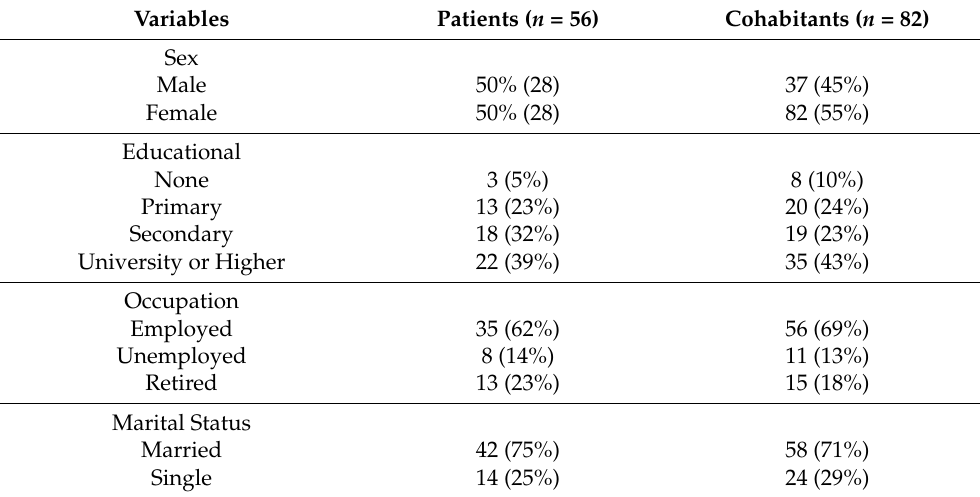
Table 1. Sociodemographic characteristics of patients and